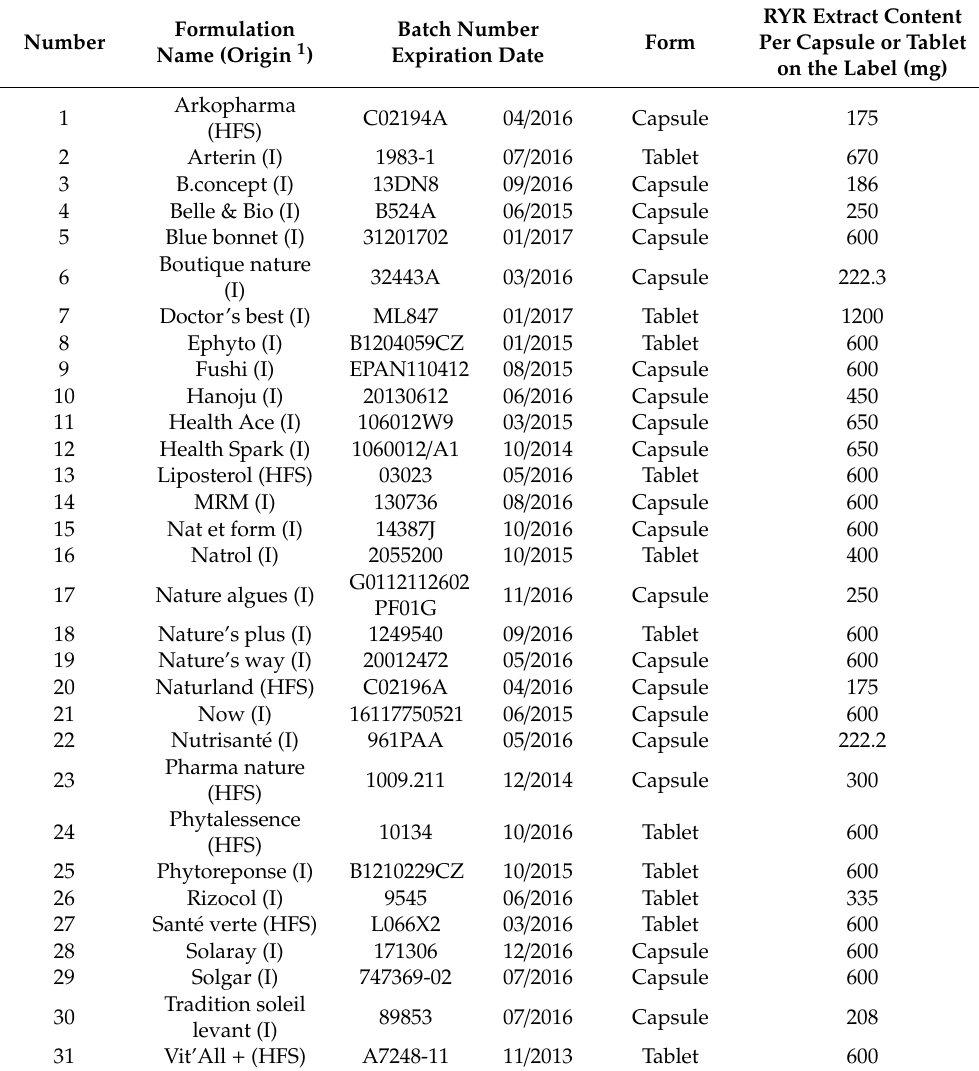
Table 1. Red Yeast Rice (RYR) dietary supplements investigated in this